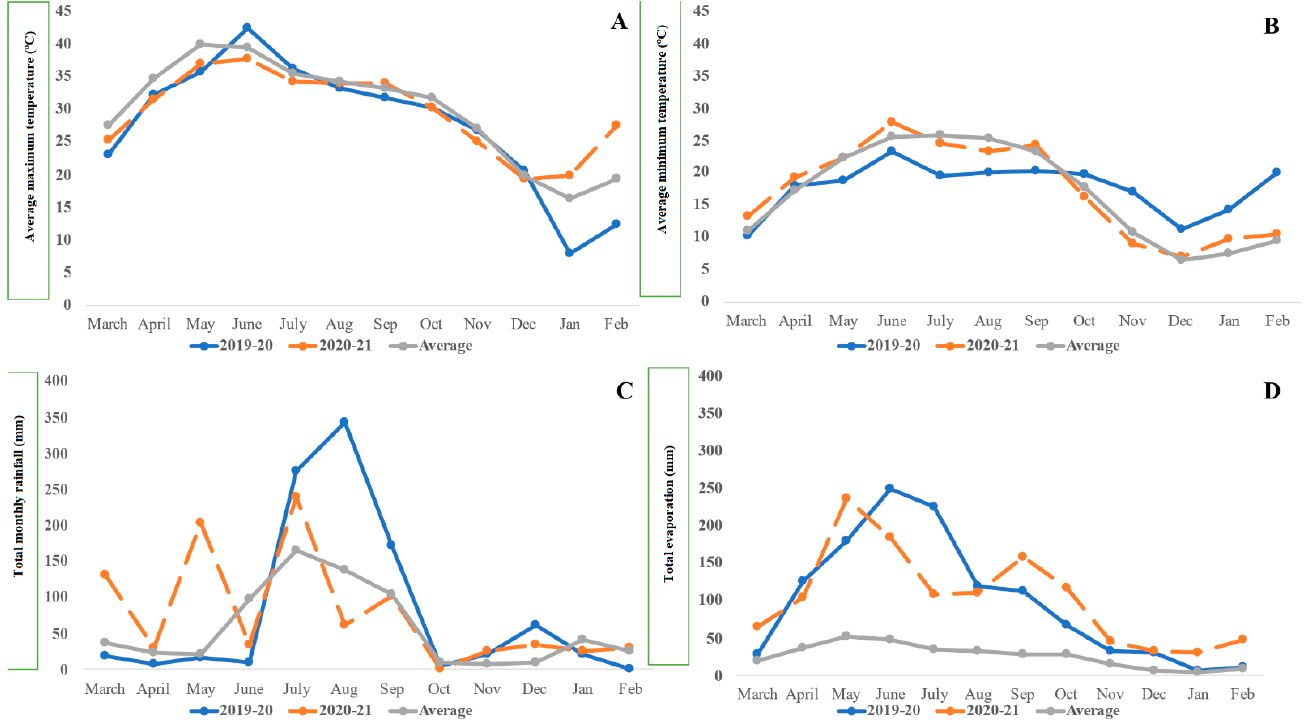
Figure 1. Different weather variables viz. average maximum ( A ) and minimum ( B ) air temperature, total rainfall ( C ), and evaporation ( D ) experience at Regional Research Station, Kapurthala on 2019–20 and 2020–21 with recorded average values from 2012.